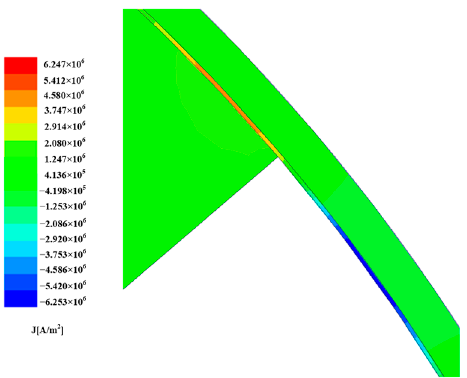
Figure 19. The eddy current density distribution for the 1-mm stainless-steel jacket, the 0.1 mm graphene shielding layer, and the PM.